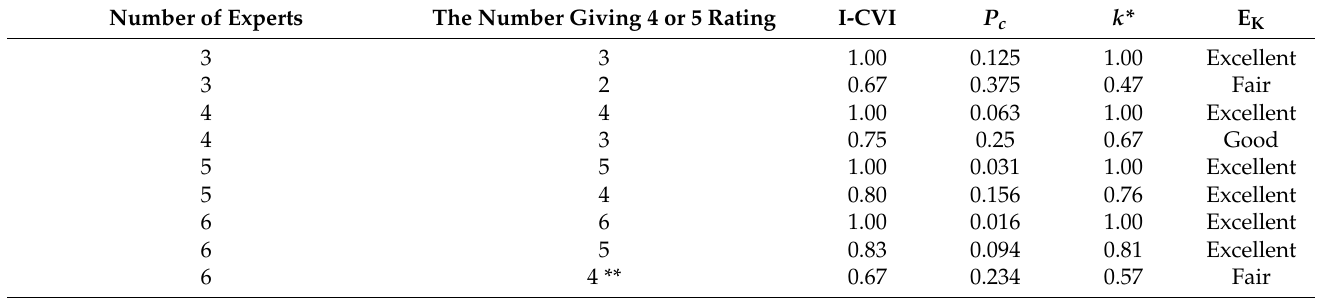
Table 4. I-CVI evaluation table and number of experts in